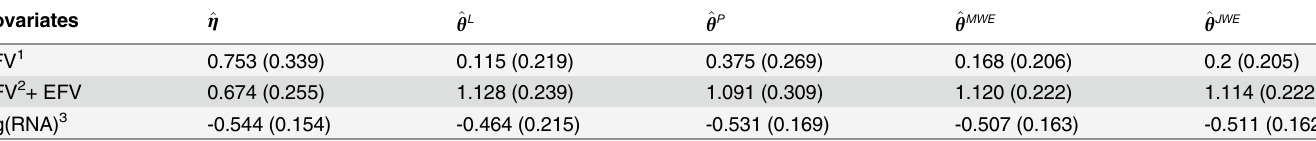
Table 5. Point estimates with standard errors of covariates in AIDS study for model without New3TC (Standard errors are shown in parenthesis).